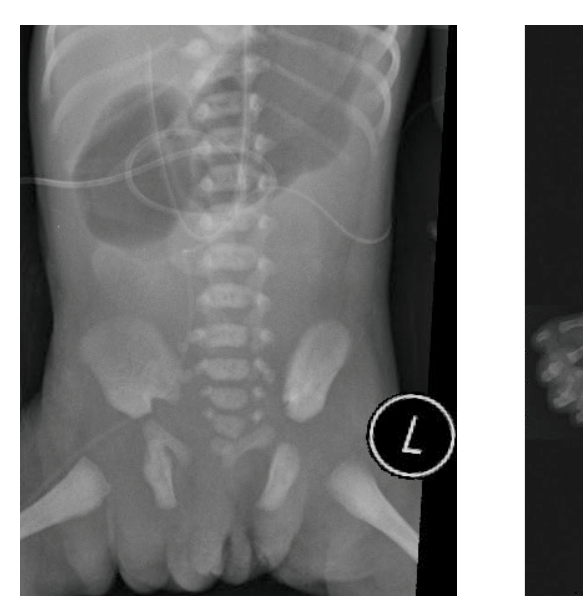
Fig. 3. Portable babygram radiograph.